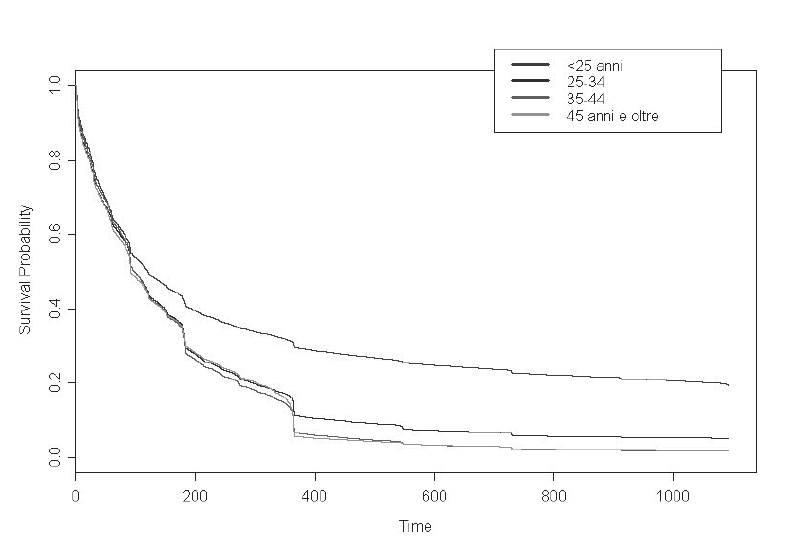
Figure 4 – Survival curves for job placements on temporary contracts, according to age